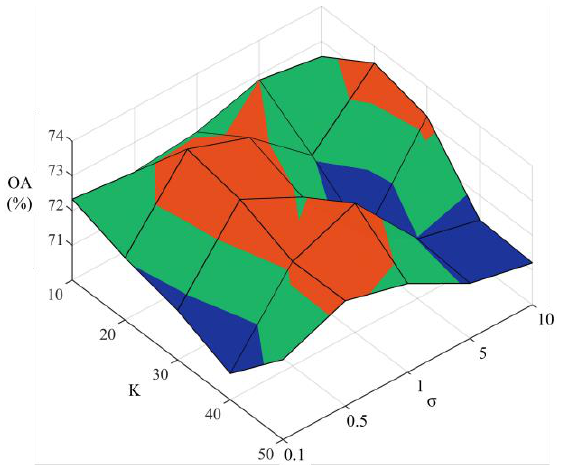
Figure 7. Adjacency matrix parameters (K, σ) impact on classification OA of miniGCN.